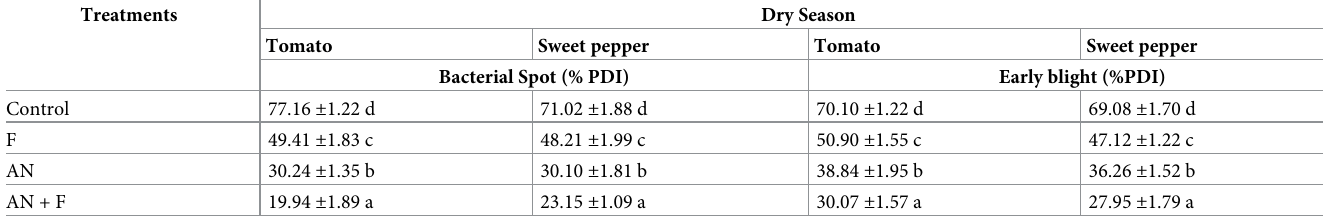
Different letters denote significant differences at 95% confidence levels according to Fisher’s protected LSD.